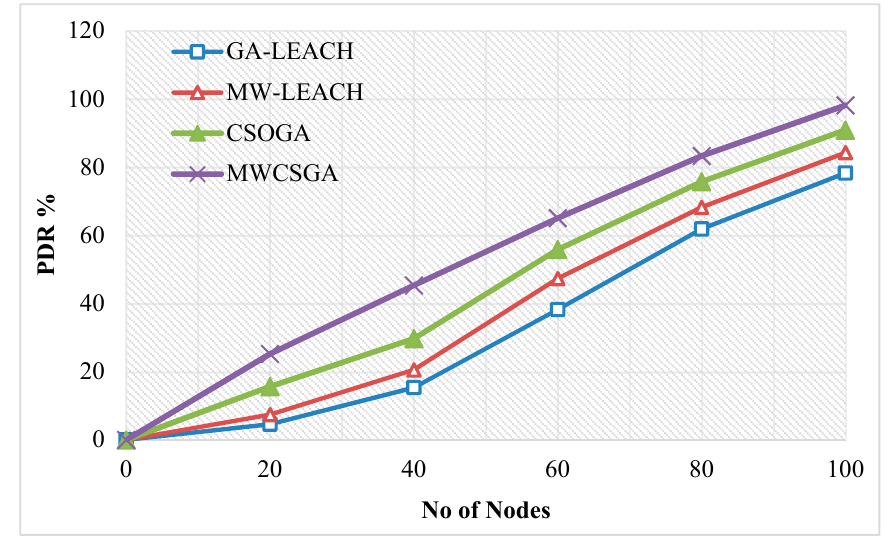
Figure 14. Packet delivery ratio calculation.